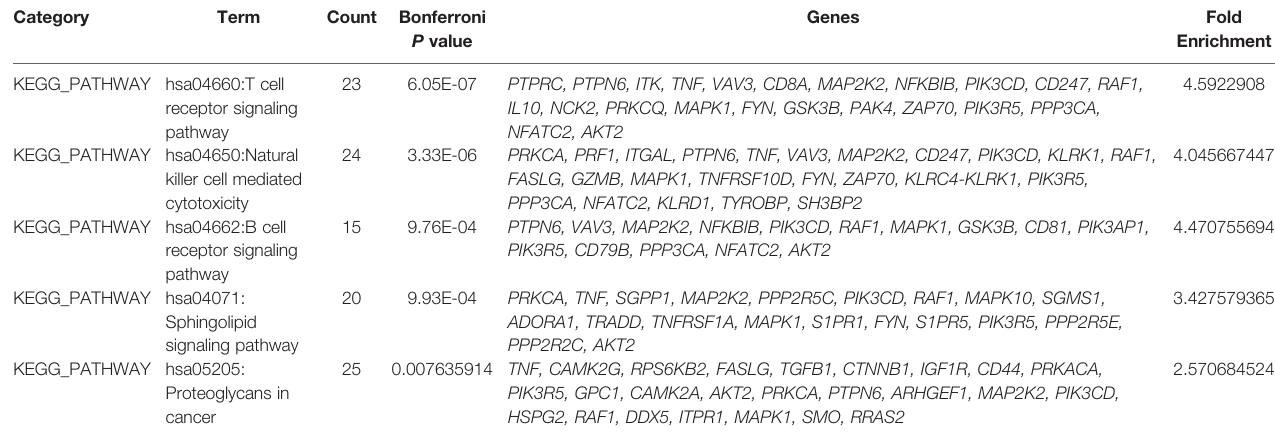
TABLE 3 | Differential methylation-associated gene KEGG pathway TOP5 in ICH.